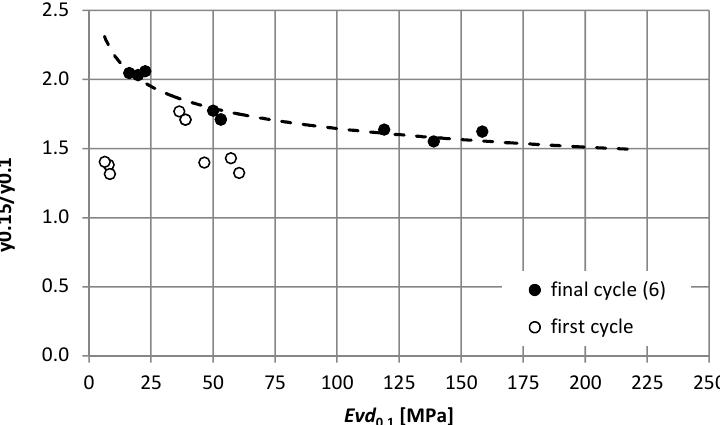
Figure 7. Dependence of the displacement ratios at two load levels (0.1 MPa and 0.15 MPa) on the dynamic modulus determined at the load of 0.1 MPa.